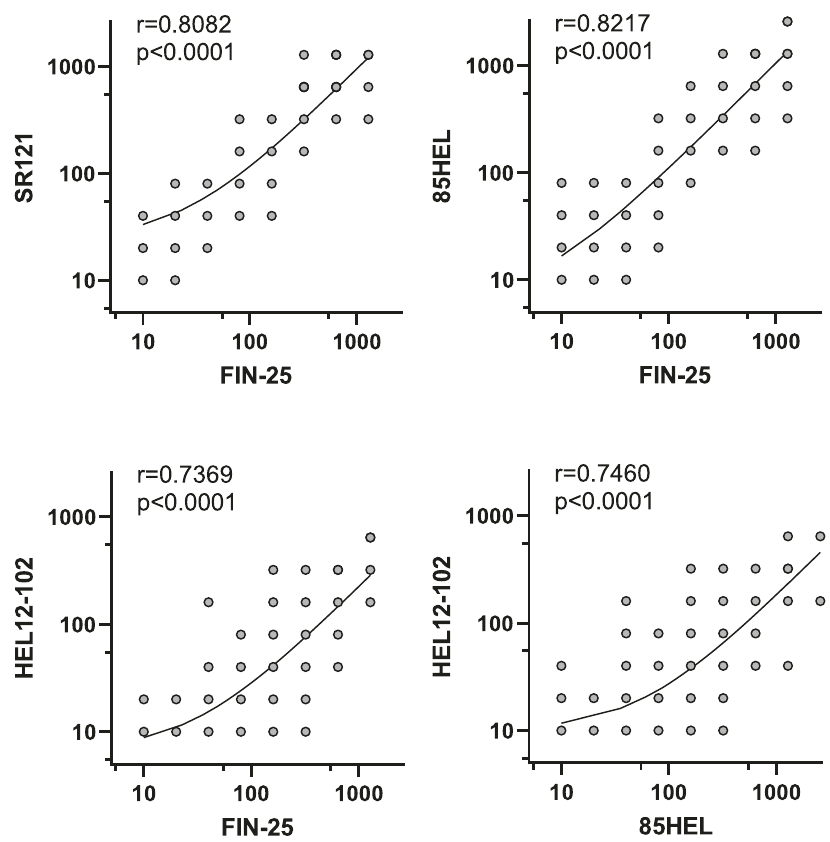
Fig. 4 Correlation of MNT titres against SARS-CoV-2 isolates. MNT titres of BNT162b2 vaccinees (initially seronegative, n = 169) against FIN-25 were compared with MNT titres against 85HEL (B.1.1.7) and HEL12-102 (B.1.351) variants including 0d, 3wk, and 6wk samples. Comparison between two D614G virus isolates, FIN-25 and SR121, was done with sera from 86 BNT162b2 vaccinees. Correlation co-ef fi cient ( r ) was calculated with Pearsons correlation test and two-tailed p -values < 0.05 were considered signi fi cant. Each dot may represent multiple